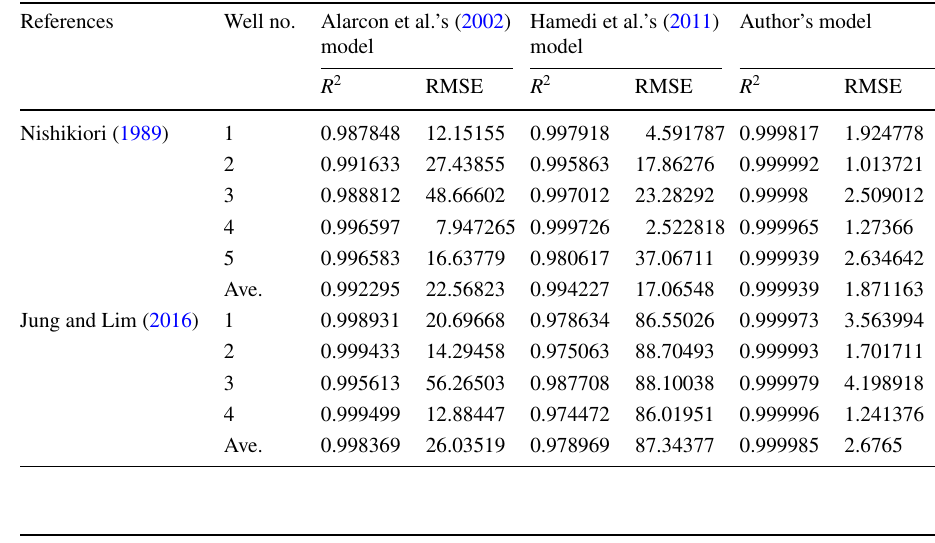
Table 2 Results of author’s model, Behjoomanesh et al.’s (2015) model, Hamedi et al.’s (2011) model and Alarcon et al.’s (2002) model for fitting operational data from Vieira (2015)